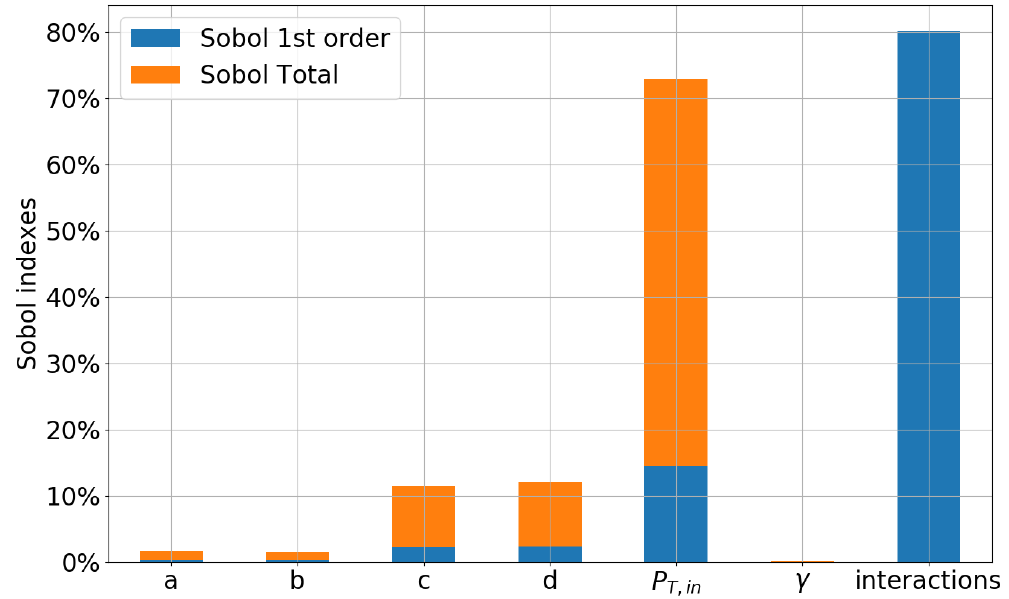
Figure 4. Global sensitivity analysis with Sobol